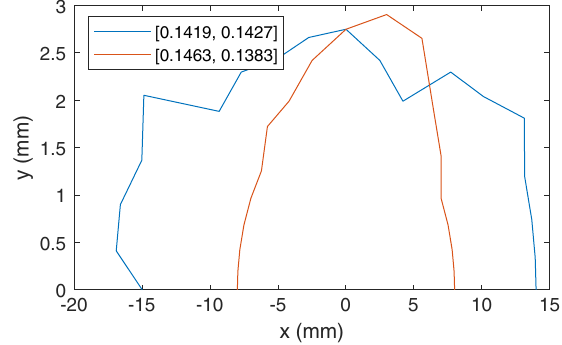
FIG. 8. Dynamic aperture from particle tracking simulation for the same two working points as Fig. 6 for the minimum coupling